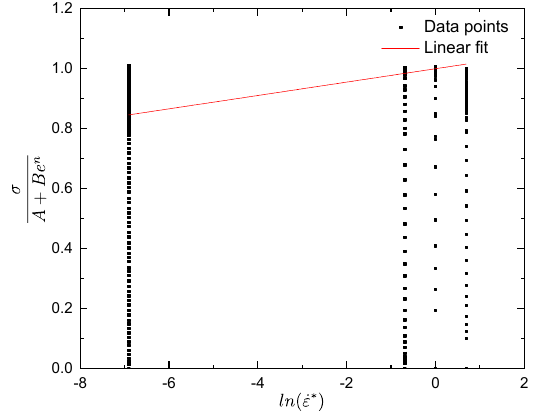
. ∗ and 𝑙𝑛𝜀(cid:4662) ∗ for four different strain rates (0.001 s − 1 , 0.5 s − 1 , 1 ε and ln for four different strain rates (0.001 s − 1 , 0.5 s − 1 , ((cid:3002)(cid:2878)(cid:3003)(cid:3084)) (cid:3289) ( A + B ε ) n